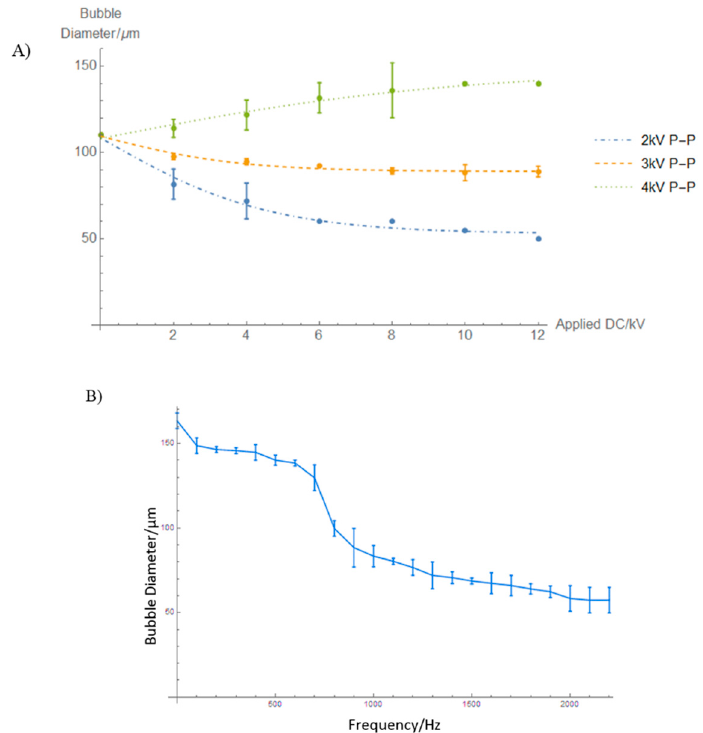
Figure 4. ( A ) Effect of applied AC electric field frequencies on the microbubble diameter. Error bars represent three standard deviations, estimated from repeat experiments. Curves represent a fit to a simple analytic function. ( B ) Variation of microbubble diameter as a function of frequency at 2 kV P–P AC voltage, 6 kV DC Voltage, 50 bubbles were used for the measurements, error bars represent three standard deviations, estimated from three repeat experiments. Measured points are connected by straight line segments as a guide to the eye.